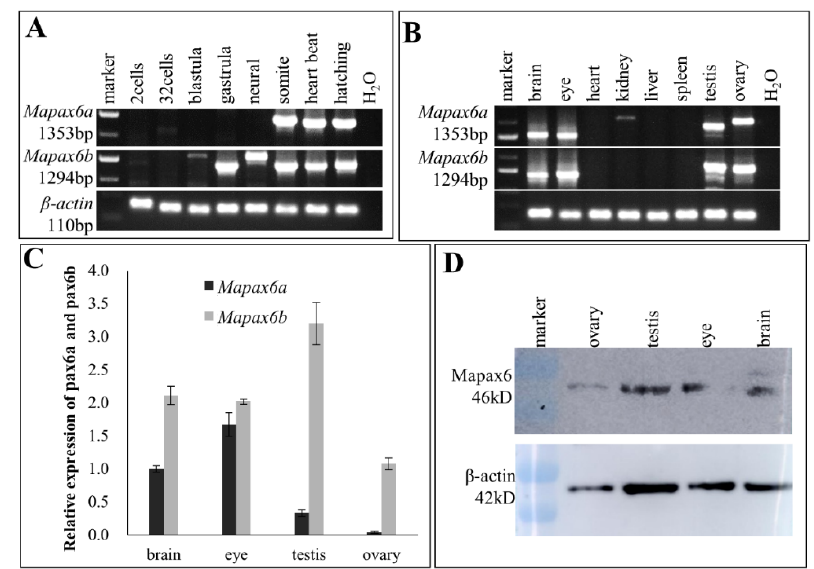
Figure 3. The expression patterns of Mapax6a and Mapax6b . ( A ) Mapax6a and Mapax6b expression in developing embryos. Mapax6a began to express at the somite stage, and Mapax6b was detected in the gastrula stage—earlier than Mapax6a . ( B ) Mapax6a and Mapax6b expression in adult tissues. Mapax6a and Mapax6b were both detected in the brain, eye, testis, and ovary. ( C ) Quantitative RT-PCR analysis of Mapax6a and Mapax6b in the brain, eye, testis, and ovary. Black bars represent Mapax6a , and gray bars represent Mapax6b . β -actin RNA was an internal reference. ( D ) Mapax6 protein detection by Western blot in different tissues. β -actin protein was an internal reference.